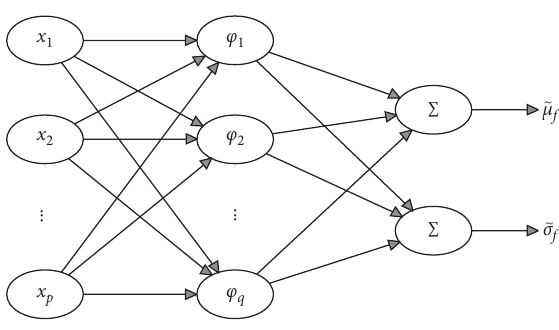
Figure 4: RBF network